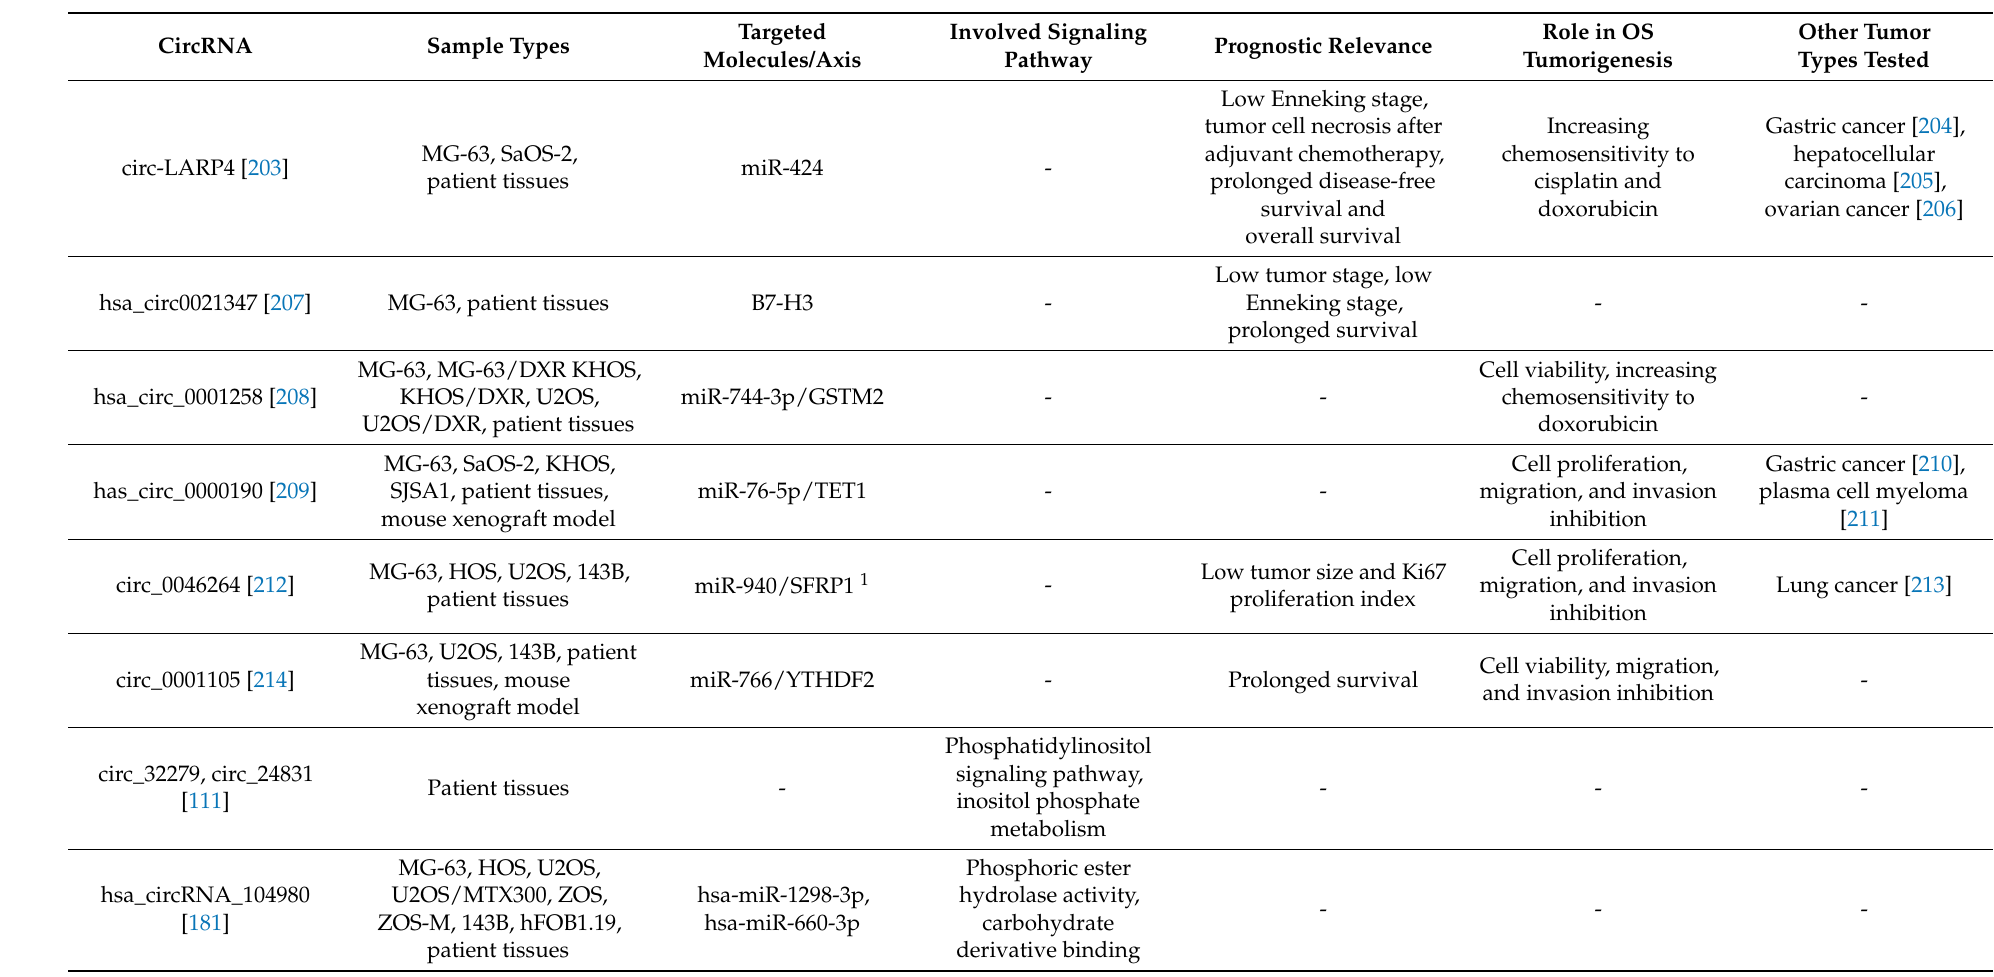
Table 2. Downregulated circRNAs in